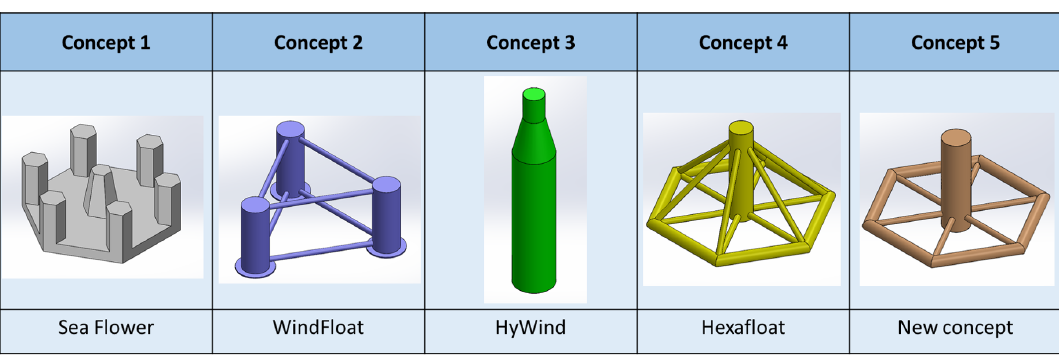
Figure 5. Platform concepts under